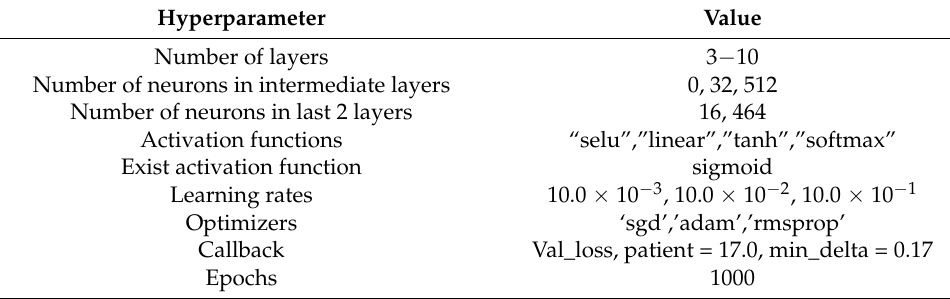
Table 3. Hyperparameters used for training the ML model. Hyperparameter Value Number of layers 3 − 10 Number of neurons in intermediate